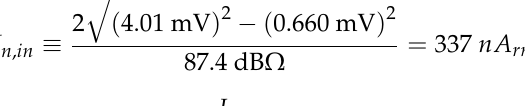
Figure 10. Measured S-parameters of the propose d Rx I C.